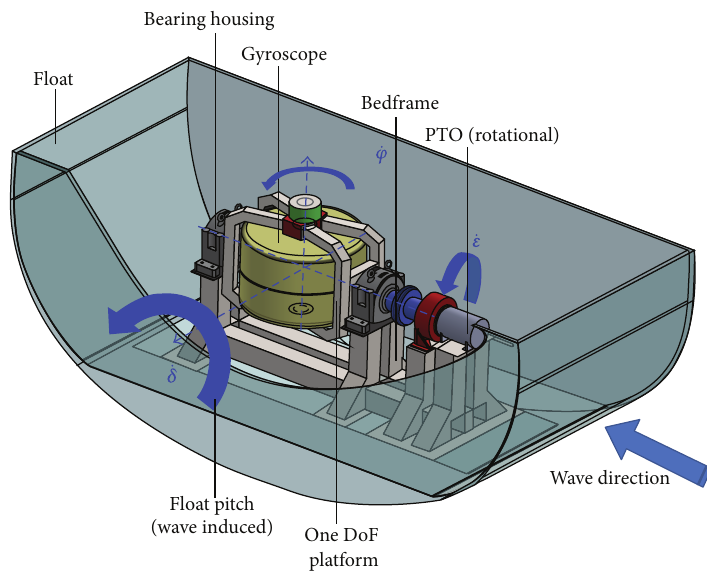
Figure 3: ISWEC layout concept.